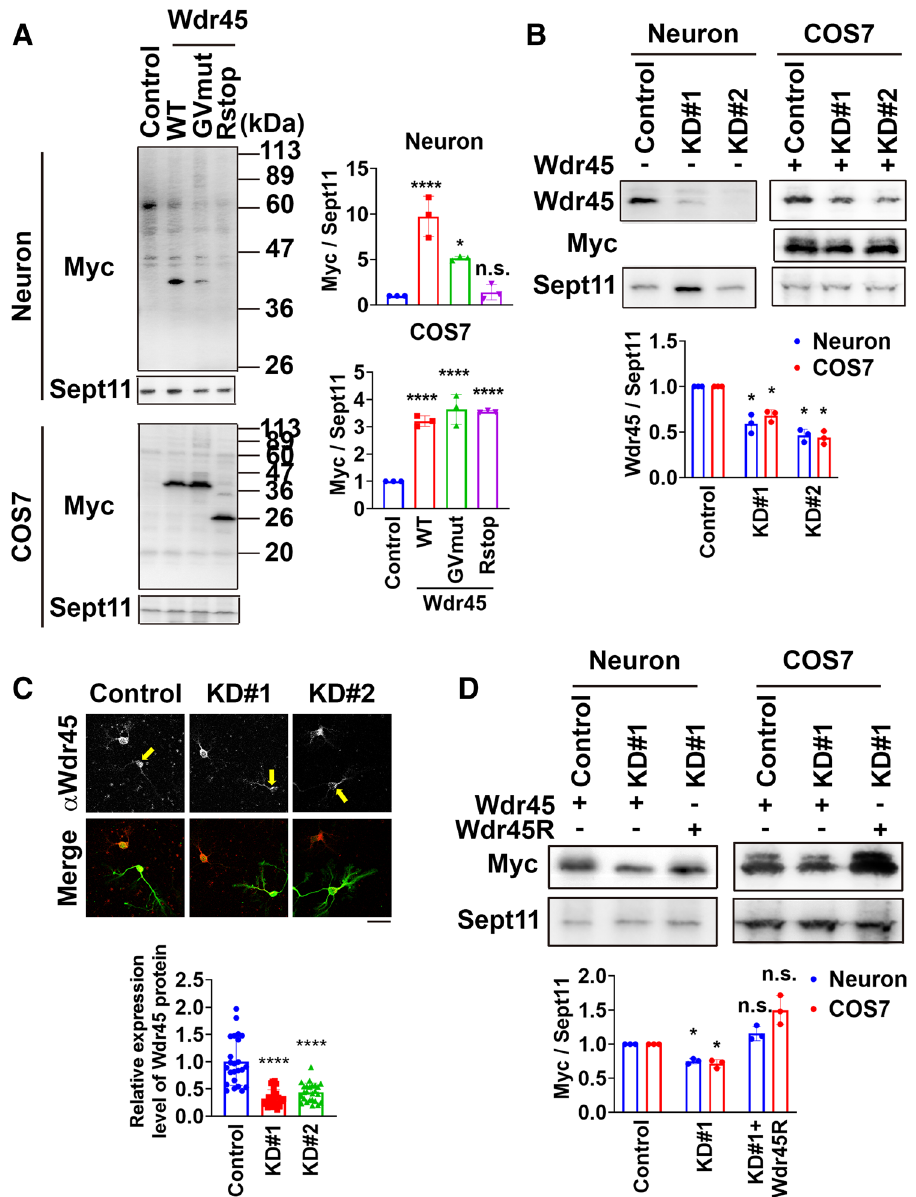
Figure 4. Characterization of vectors for expression and RNAi. ( A ) Expression of wild type Wdr45 and 2 mutants, c.700C > T/p. (Arg234*) (Wdr45-Rstop) and c.439G > T/p.(Gly167Val) (GVmut), in dissociated mouse cortical neurons or COS7 cells. Neurons isolated at E14 and COS7 cells were transfected with pCAG vector (control), pCAG-Myc-Wdr45 (WT), -Wdr45-GVmut or -Wdr45- Rstop, and cultured in vitro for 13 days (neurons) and cultured for 48 h (COS7 cells). Cells were then subjected to western blotting with anti-Myc. Anti-Sept11 was used for a loading control. For quantification, Myc-band intensities were quantified densitometrically and normalized against the loading control. The values were plotted and error bars indicate SD (n = 3); * p < 0.05, **** p < 0.0001, n.s. means not significant by one-way ANOVA with Tukey’s post hoc test. ( B ) Knockdown of endogenous Wdr45 in dissociated mouse cortical neurons or exogenous Wdr45 in COS7 cells. Neurons were co-transfected with pCAG-EGFP together with pSuper-H1.shLuc (Control), pSuper-Wdr45#1 (KD#1) or #2 (KD#2). COS7 cells were co-transfected with pCAG-Myc-Wdr45 together with pSuper-H1. shLuc (Control), pSuper-Wdr45#1 (KD#1) or #2 (KD#2). After culture for 13 days and 48 h for neurons and COS7 cells, respectively, cells were harvested and subjected to western blotting with anti-Wdr45 or anti-Myc. Anti-SEPT11 was used for loading control. Band intensities were quantified as in ( A ). The values were plotted and error bars indicate SD (n = 3); * p < 0.05 by one-way ANOVA with Tukey’s post hoc test. ( C ) Immunostaining of dissociated cortical neurons. pCAG-EGFP was co-transfected with pSuper-H1. shLuc (Control), pSuper-Wdr45#1 or #2 into neurons as in ( A ), and cultured for 72 h. After fixation, cells were immunostained with anti-GFP (green) and anti-Wdr45 (red). Wdr45 expression levels were estimated by measurement of fluorescence intensity. The values normalized to the control average value were plotted. Error bars indicate SD; n = 3 experiments involving independent batches of neurons cultured from different embryos. At least 10 neurons were analyzed for each group; **** p < 0.0001 by one-way ANOVA with Dunnett’s post hoc test. Scale bars, 50 μm. ( D ) Characterization of RNAi-resistant Wdr45. pCAG-Myc-Wdr45 or pCAG-Myc-Wdr45R was co-transfected into dissociated mouse cortical neurons or COS7 cells with pSuper-H1.shLuc (Control), pSuper-Wdr45#1 or #2. Cells were further cultured and then subjected to western blotting as in ( B ) Myc-band intensities were quantified as in ( B ). The values were plotted and error bars indicate SD (n = 3); * p < 0.05, n.s. means not significant by one-way ANOVA with Tukey’s post hoc test. Uncropped blots are shown in Supplementary Figs.